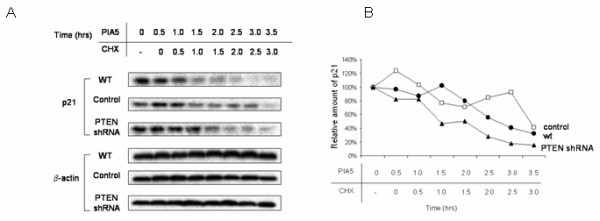
Stabilization of p21 in PTEN-knockdown cells is abrogated by Akt inhibition. a. Wild type ACHN cells as well as those stably transfected with PTEN-shPNA or empty vector were incubated with the phosphatidylinositol ether lipid analog PIA5 (10 μM), which prevents Akt activation, for the times indicated in the presence or absence of cycloheximide (CHX;20 μg/ml), and cell lysate was immunoblotted with antibodies against p21 and β-actin. b. A graphical representation of the data using densitometry of p21 and β-actin bands is reported as ratio of p21/actin and is normalized to the "0 CHX control" foreach lane. A representative experiment is shown of three done.